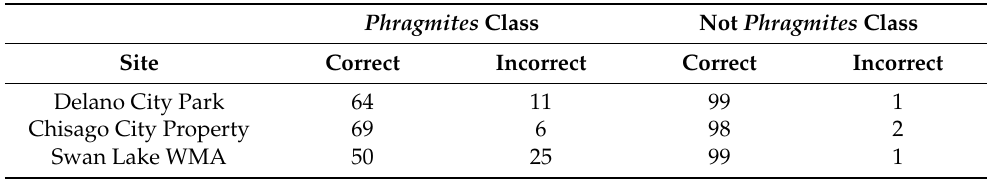
Table 20. Validation assessment points for each of the three validation sites for the support vector machine classification with the post-ML OBIA rule set.